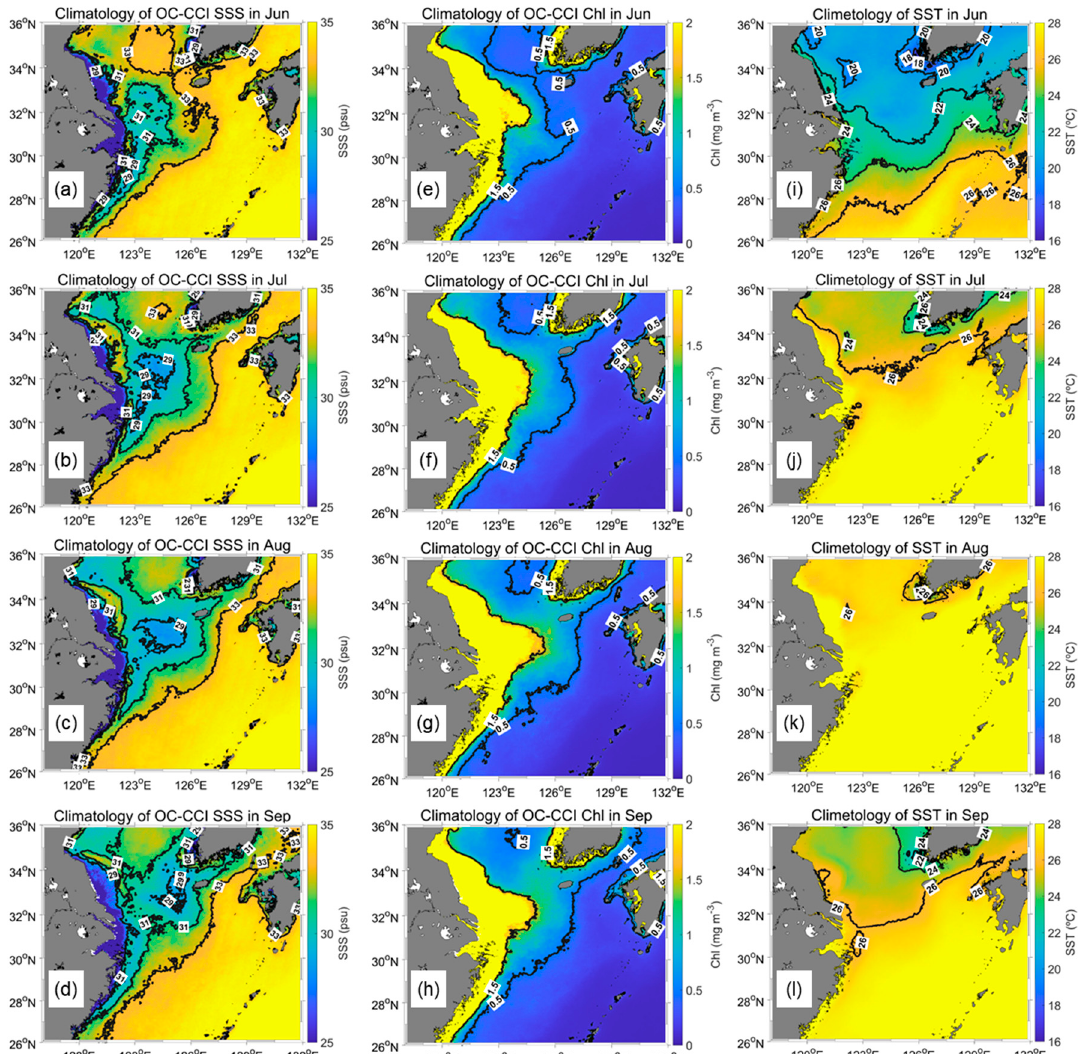
Figure 5. Climatology of OC-CCI ( a − d ) SSS and ( e − h ) Chl from June to September between 1997 and 2021. ( i − l ) Climatology of MODIS SST from June to September between 2002 and 2021.